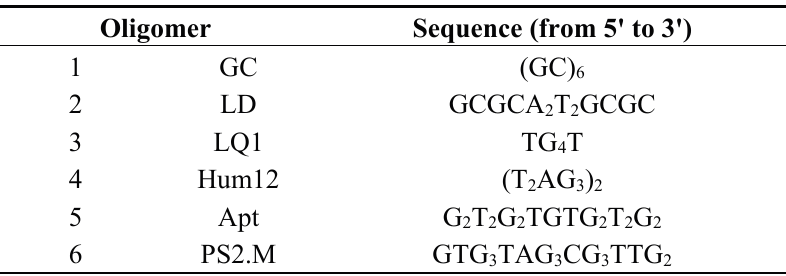
Table 1. Oligomers used in the fluorescence test of quinaldine red